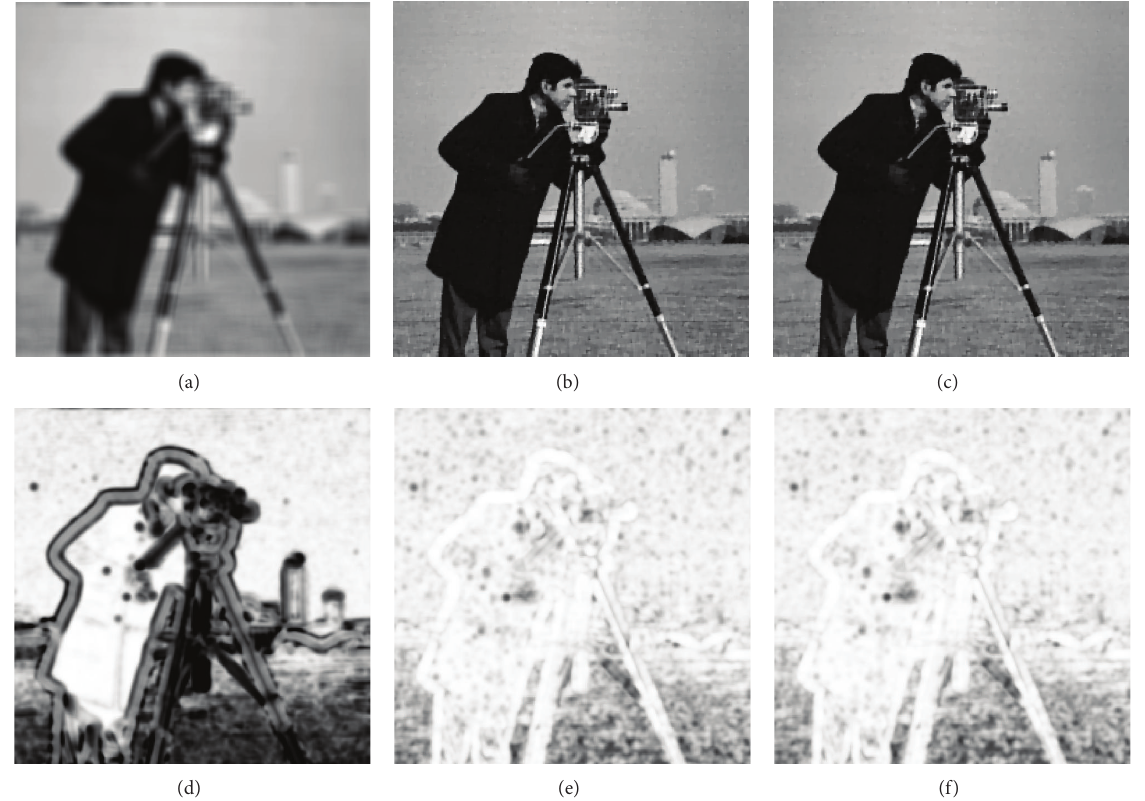
Figure 2: Results of different methods when restoring blurred and noisy image “Cameraman” degraded by average 9 × 9 uniform blur and a noise with BSNR = 40 dB: (a) blurred and noisy image “Cameraman”; (b) restored image by FastTV; (c) restored image by FNDTV; (d) SSIM index map of the corrupted image; (e) SSIM index map of the recovered image by FastTV; (f) SSIM index map of the recovered image by